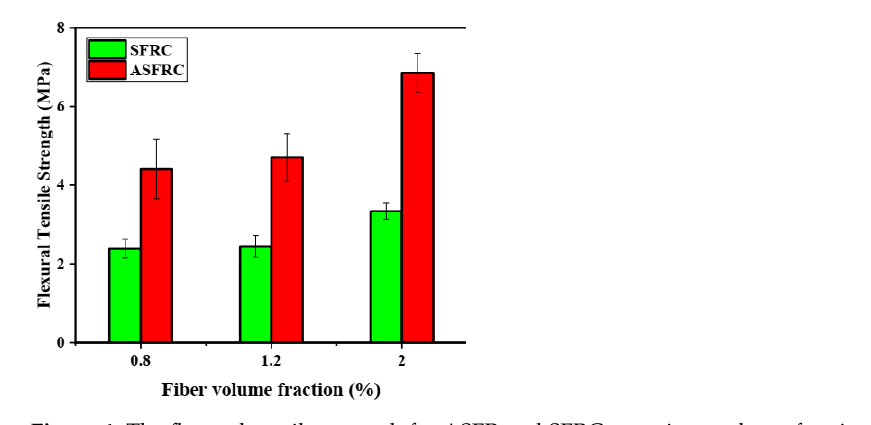
Figure 4. The flexural tensile strength for ASFR and SFRC at various volume